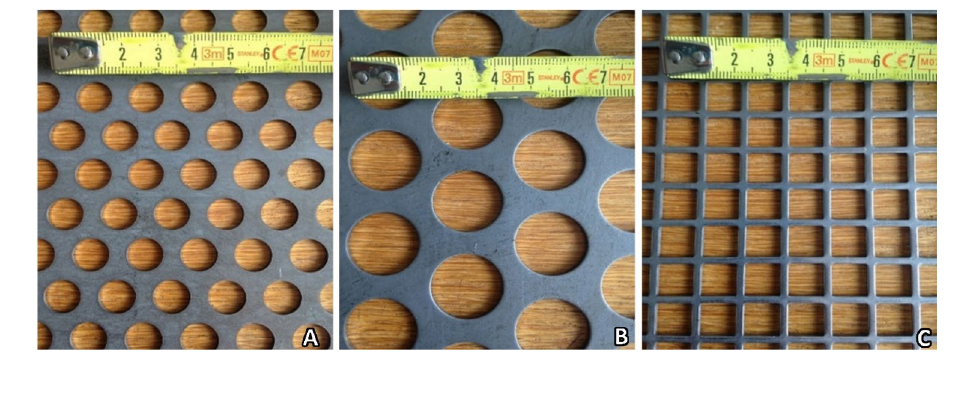
Fig. 4 A Plate of expanded metal, open area of 24%, hole size of 45 mm * 13 mm, thick- ness of 3 mm, apparent thick- ness of 9 mm, strand of 5 mm; B piece of cast metallic foam, cell size of 30 mm with holes of 12 and 5 mm